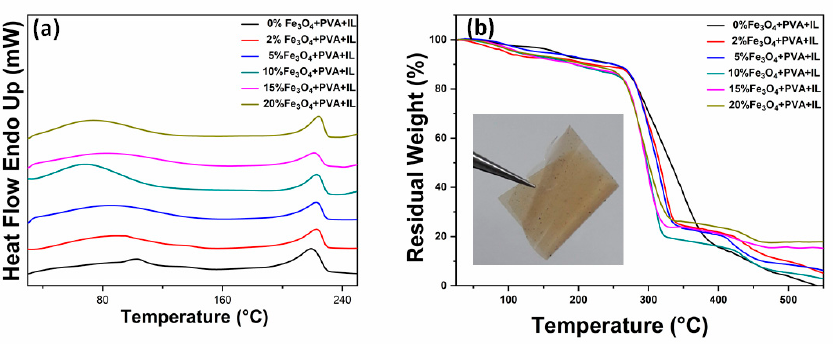
Figure 3. ( a ) Differential scanning calorimetry (DSC) thermograms and ( b ) thermal gravimetric analysis of the polyvinyl alcohol (PVA)-glycerol-Fe 3 O 4 membranes at different wt% concentrations of nanoparticles. The inset in ( b ) shows a membrane with 10% Fe 3 O 4 . IL refers to glycerol in the legend. TGA analysis for the PVA-GL-Fe 3 O 4 membranes was utilized to identify the sta- bility and the loading amount of Fe 3 O 4, and its results are depicted in Figure 3b, with